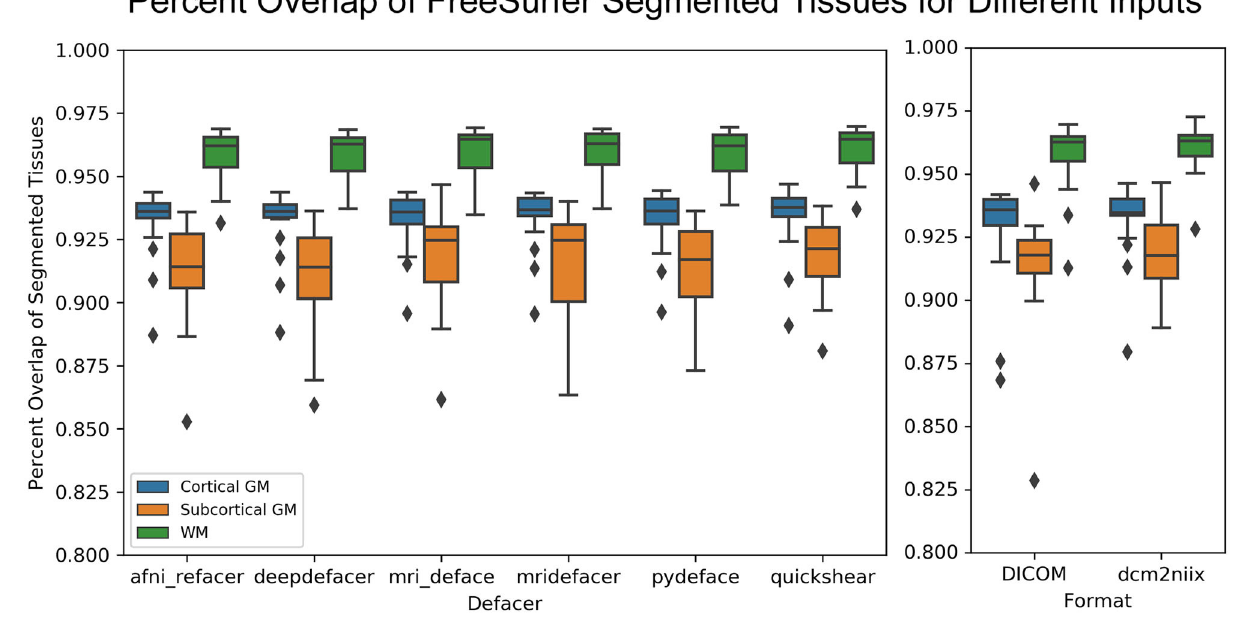
FIGURE 8 | Boxplot showing the percent overlap of FreeSurfer segmented tissues for the defaced scans (left) and different file formats (raw DICOM and NIfTI files converted using alternate method, right), as defined by the area of the intersection with the original input scan, divided by the area of the union with the original, for that